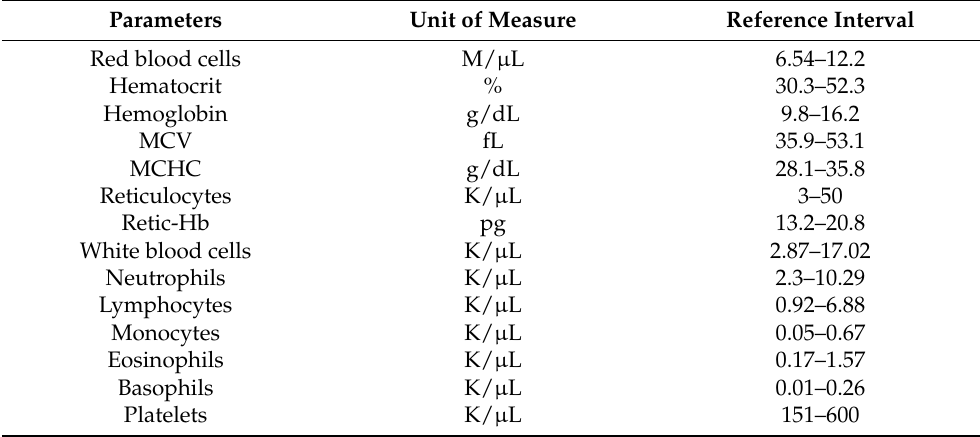
Table 1. IDEXX ProCyte Dx reference intervals of complete blood count (CBC) parameters considered for statistical evaluation.